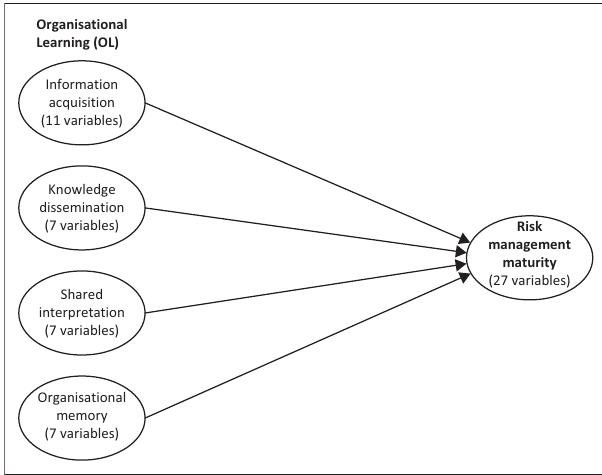
FIGURE 1: Relationship between organisational learning components and risk management